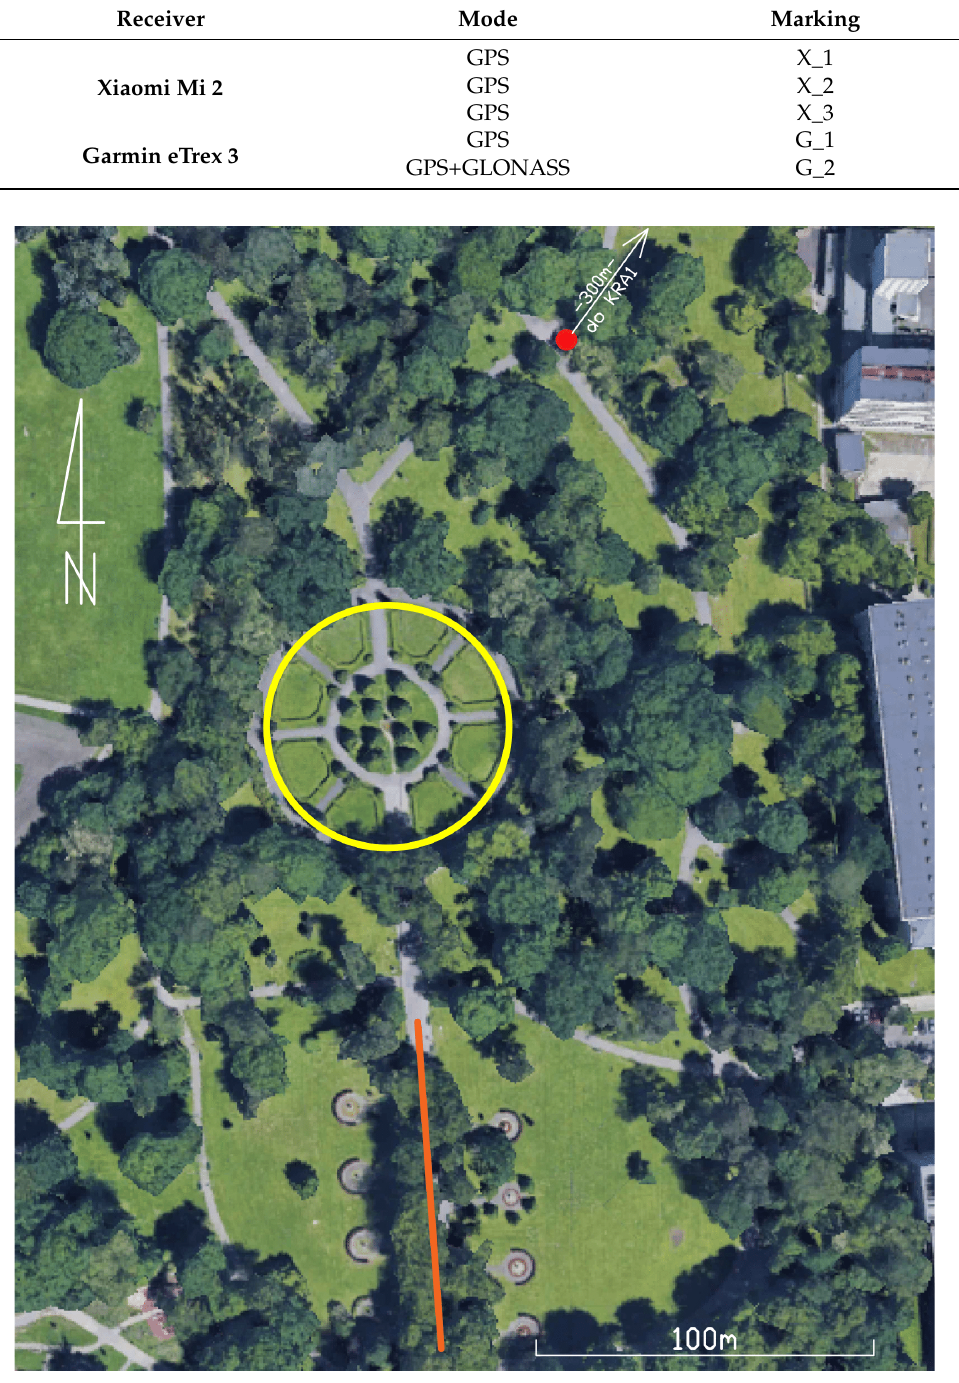
Figure 2. Location of measurement objects. Orange—linear object, yellow—surface object, red—point object, coordinates of the center of the yellow circle: 50°03 ′ 45.9 ″ N 19°55 ′ 02.9 ″ E, 204 m (background source: Google Earth). Table 1. Summary of receivers used for measurement.